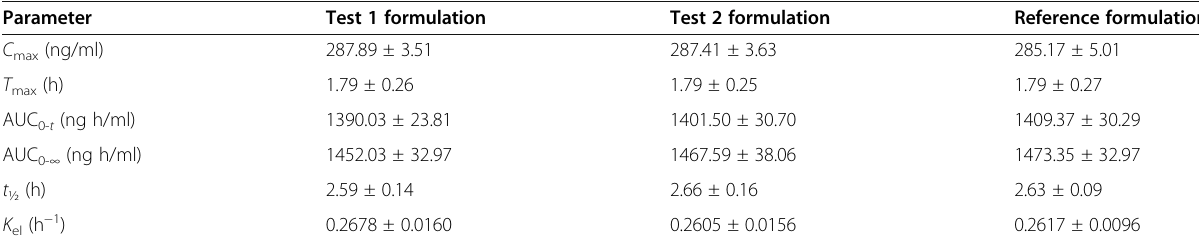
Table 2 Mean vildagliptin pharmacokinetic parameters (± SD) after the last administration of the test 1, test 2, and reference formulations